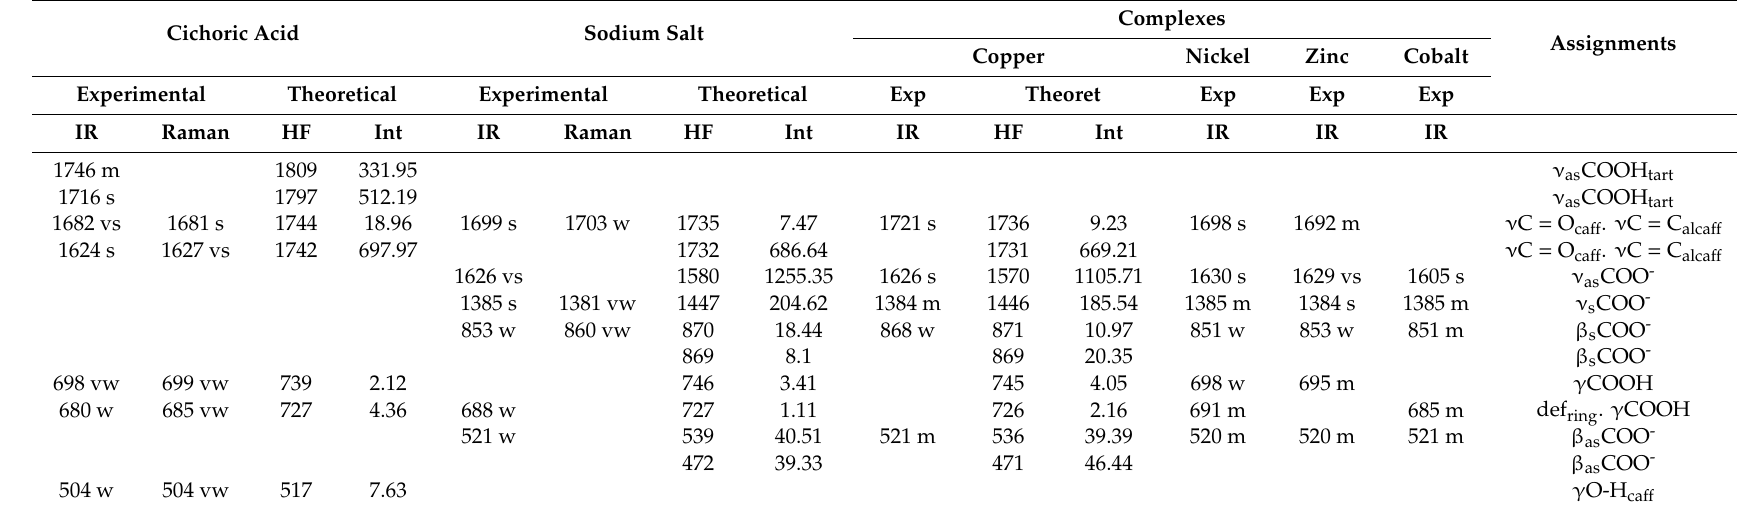
Table 2. Wavenumbers (cm − 1 ), intensities, and assignments of bands occurring in the IR (Infrared) (KBr and HF –Hartrre-Fock method) and Raman spectra of cichoric acid, sodium salt, and 3D metal